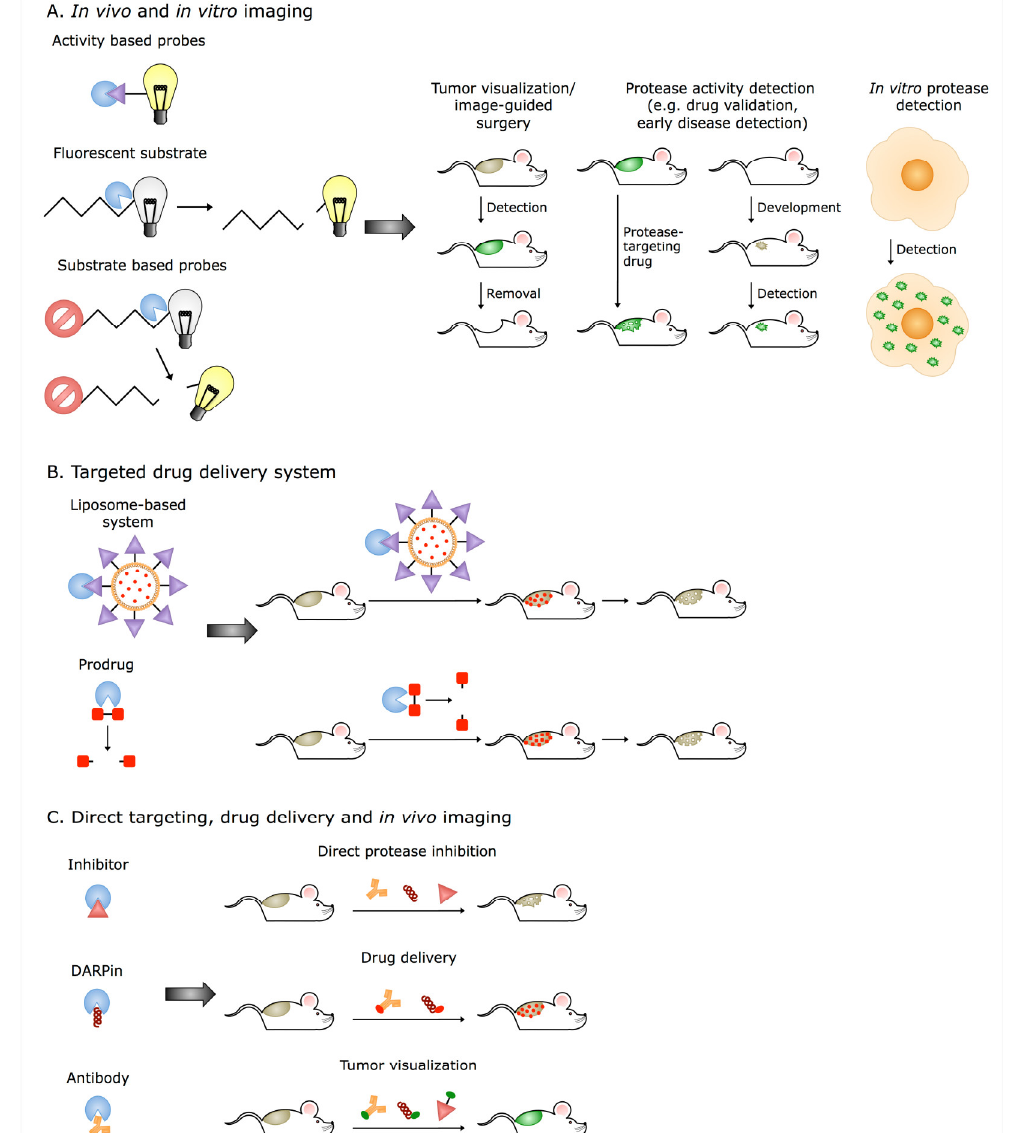
Figure 3. Extracellular cathepsins as diagnostic targets, prodrug activators, and targets for targeted drug delivery. The high levels of cathepsins in the ECM can be utilized in different imaging and targeting techniques. ( A ) Fluorescent substrates, substrate-based probes, and activity-based probes are the most commonly used tools for in vivo and in vitro imaging. ( B ) Extracellular cathepsins can be also used for targeted drug delivery and for prodrug activation. ( C ) Since many cathepsins are also overexpressed and active in different cancers, they can be targeted directly using their inhibitors, designed ankyrin repeat proteins (DARPins), or antibodies. These molecules can also be conjugated and, as such, used for drug delivery and tumor visualization.